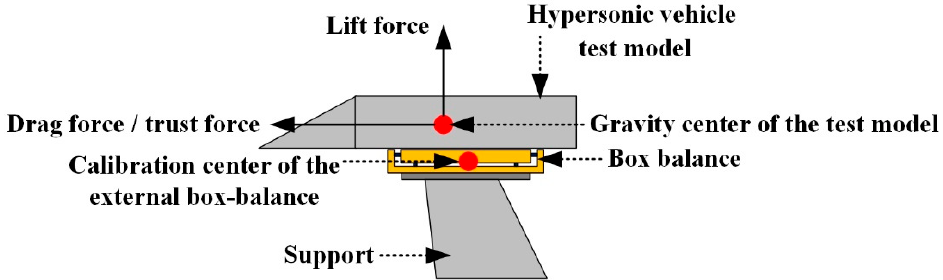
Figure 5. Three-dimensional model diagram of external box-balance. Table 1. Interference analysis among test channels of the AFMS.